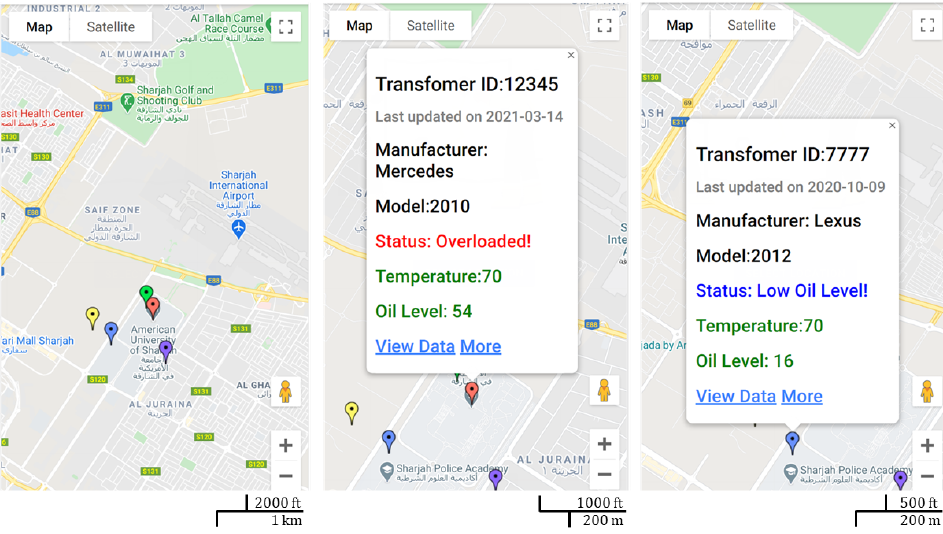
Figure 7. Map markers indicating status on mobile